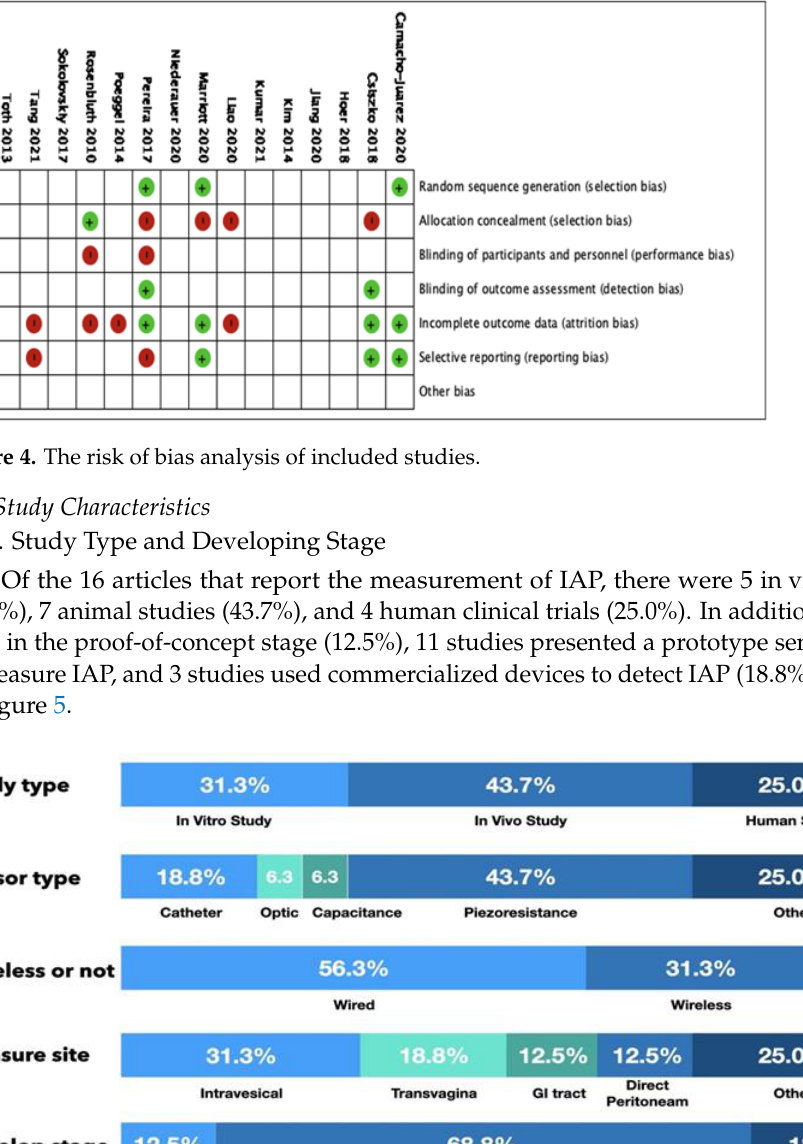
Figure 3. The summary of risk of bias of included studies.